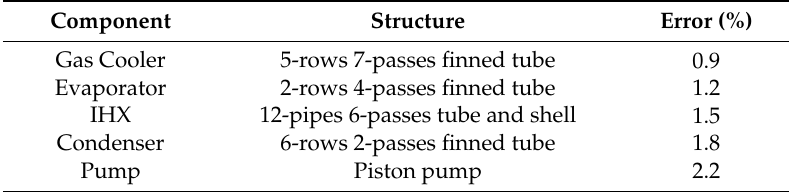
Table 4. Structure of some components and errors of GT-Power model.